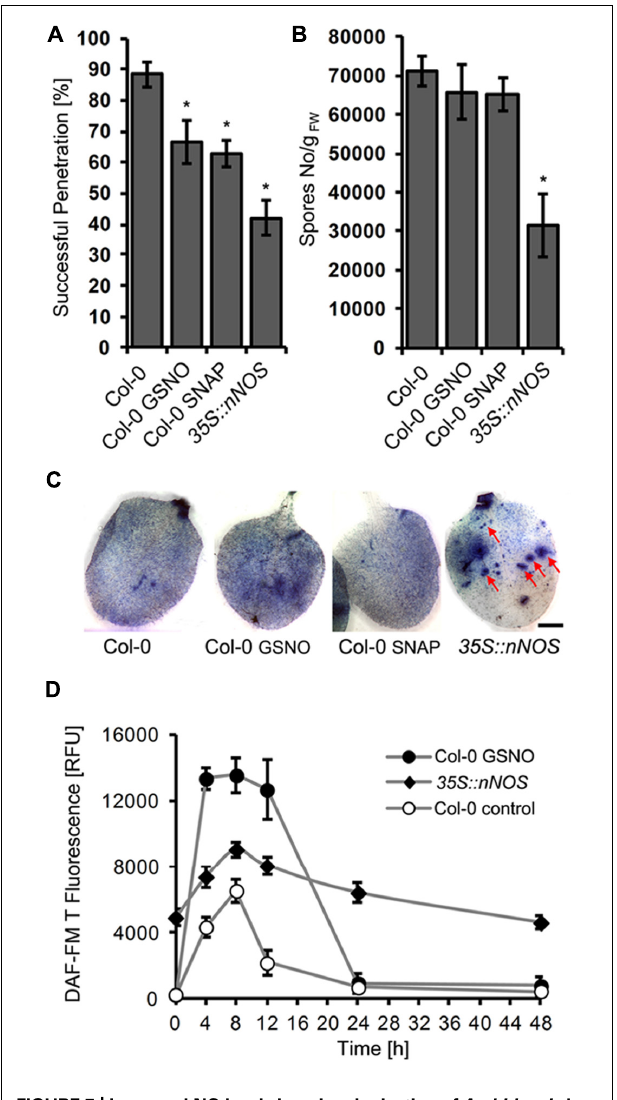
FIGURE 7 | Increased NO levels impair colonization of Arabidopsis by Golovinomyces orontii. Six week-old Arabidopsis wild type (Col-0) was infiltrated with NO donors, 200 μ M GSNO, 100 μ M SNAP, or DMSO (control) 2 h before inoculation with G. orontii spores, whereas the Arabidopsis mutant 35S::nNOS was inoculated without prior treatment. (A) Quantification of host cell entry rates determined 48 h post-inoculation (hpi). Data represent the mean ( ± SD) of at least six leaves taken from two different plants. (B) Production of spores at 7 days post-inoculation (dpi) normalized to leaf fresh weight. Data represent the mean ( ± SD) of at least four different leaves. Asterisks in both graphs ( A and B ) indicate a significant difference ( p < 0.01) of treated plants/mutant relative to untreated wild type. (C) Representative micrographs of infected leaves, harvested at 7 days post-inoculation (dpi), following staining with Coomassie Brilliant Blue to visualize fungal structures and host cells that have undergone HR cell death.The Arabidopsis wild type is covered with sporulating colonies and this phenotype is not altered by prior treatment with GSNO or SNAP. By contrast, the 35S::nNOS line is only partially colonized and developed intensely stained lesions (HR cell death) at high frequency (red arrows). Bar = 25 mm. (D) Time course of NO formation in Arabidopsis wild type (Col-0) and 35S::nNOS plants upon inoculation with the adapted powdery mildew fungus, G. orontii . NO quantification at infection sites was carried out as described in Figure 1 .Values represent the mean ( ± SD) of at least 20 infection sites taken from four different